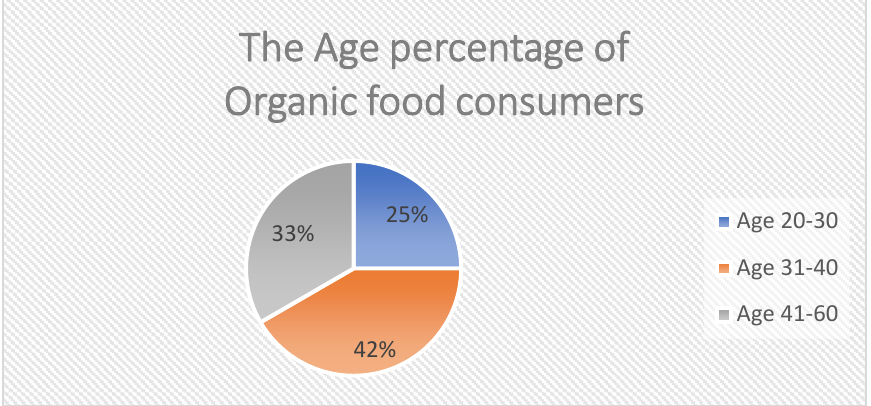
Table 2. Consumers’ background information.